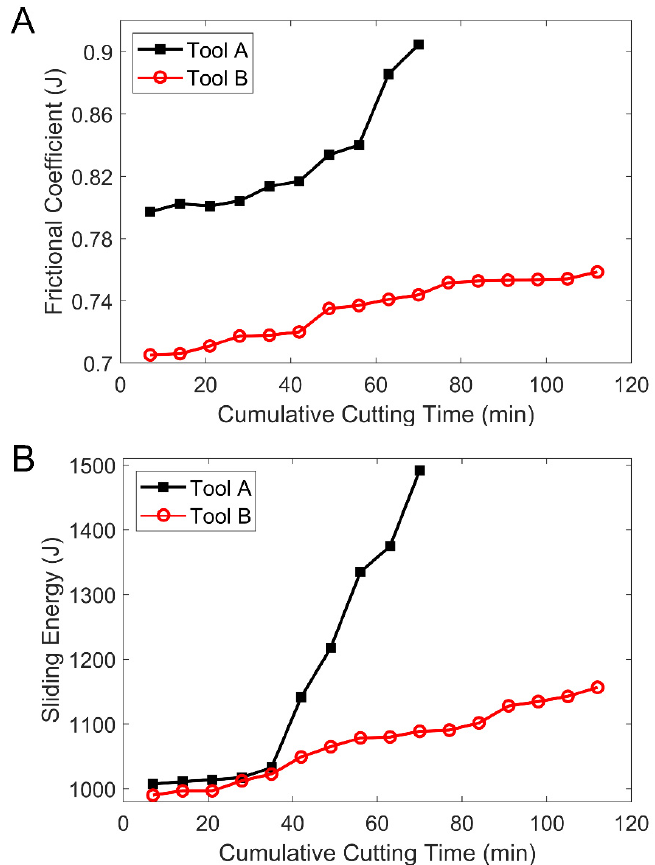
Figure 9. ( A ) Comparison curves of frictional coefficients of Tool A and Tool B over time. ( B ) The sliding energy curves of Tool A and Tool B over time. energy curves of Tool A and Tool B over